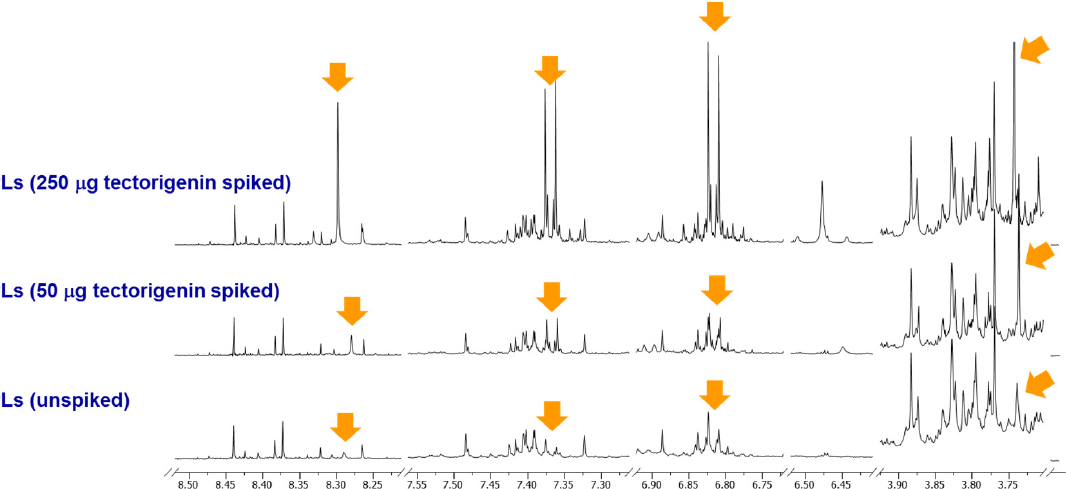
Figure 3. Stacked 1 H NMR spectra of the unspiked PLs (MeOH sonication), 50 μ g tectorigenin ( 2 ) spiked, and 250 μ g tectorigenin ( 2 ) spiked samples.